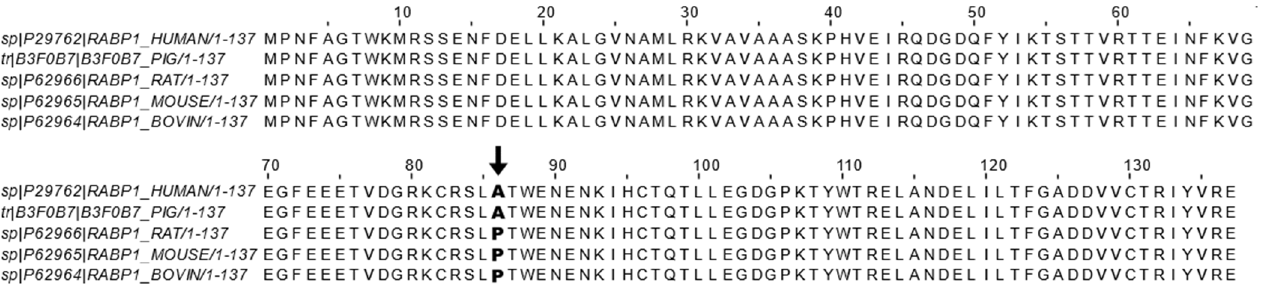
Figure 1. CRABP1 sequence alignment across mammals. Reported CRABP1 protein sequences from the Uniprot database of human (ID: P29762) [41], pig (ID: B3F0B7) [42], rat (ID: P62966) [43], mouse (ID: P62965) [44], and bovine (ID: P62964) [45] were aligned using the ClustalWS alignment algorithm in Jalview. Only the residue at position 86 (indicated by bold text and arrow ↓ ) is not conserved and exists either as an alanine (A) in human and pig sequences or as a proline (P) in bovine, rat, and mouse sequences.